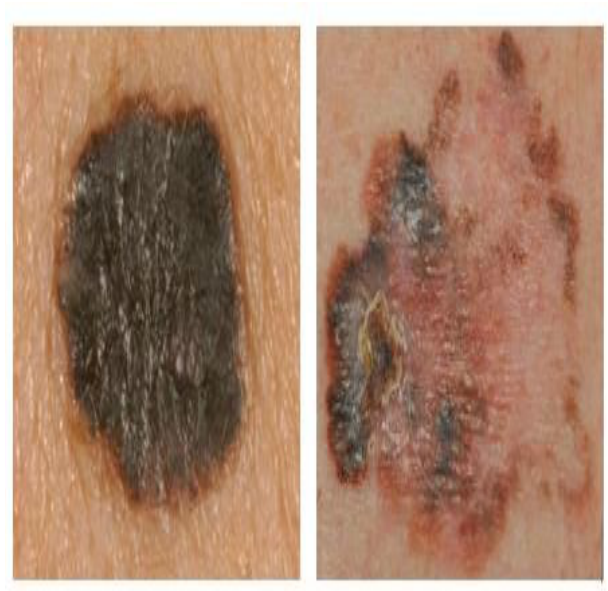
Figure 1. A :Symmetric and B : Asymmetric melanoma lesions.